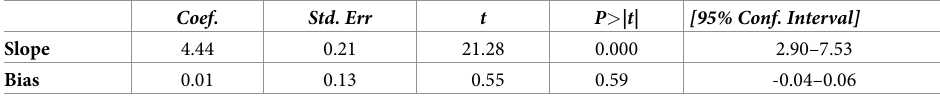
Platelet activation plays a critical role in thrombosis and inflammation in physiopathology. The RDW and MPV have been shown in several studies to be useful in the diagnosis of IBD. Table 2. Egger’s test